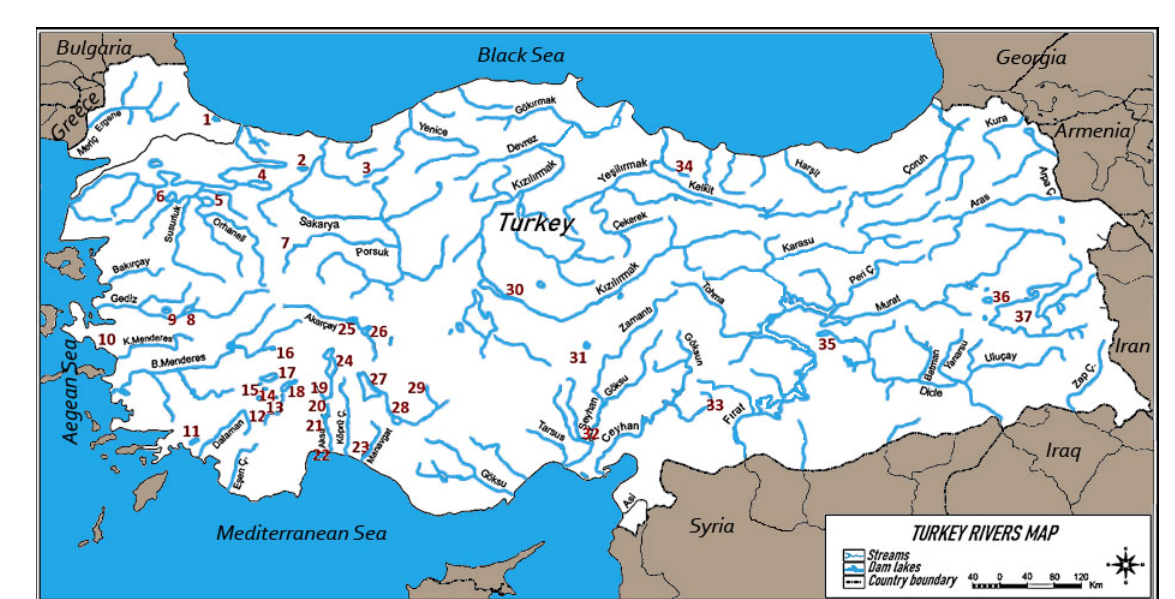
Figure 1. Map reporting the locations * of the 37 lakes in Turkey considered in the study, together with their river systems